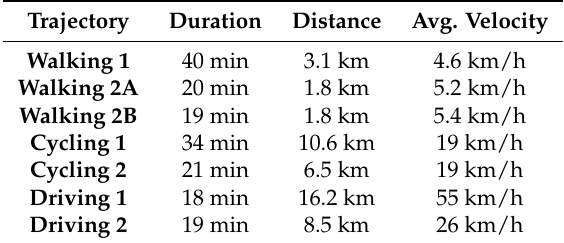
Table 1. Characteristics for the 7 mobile